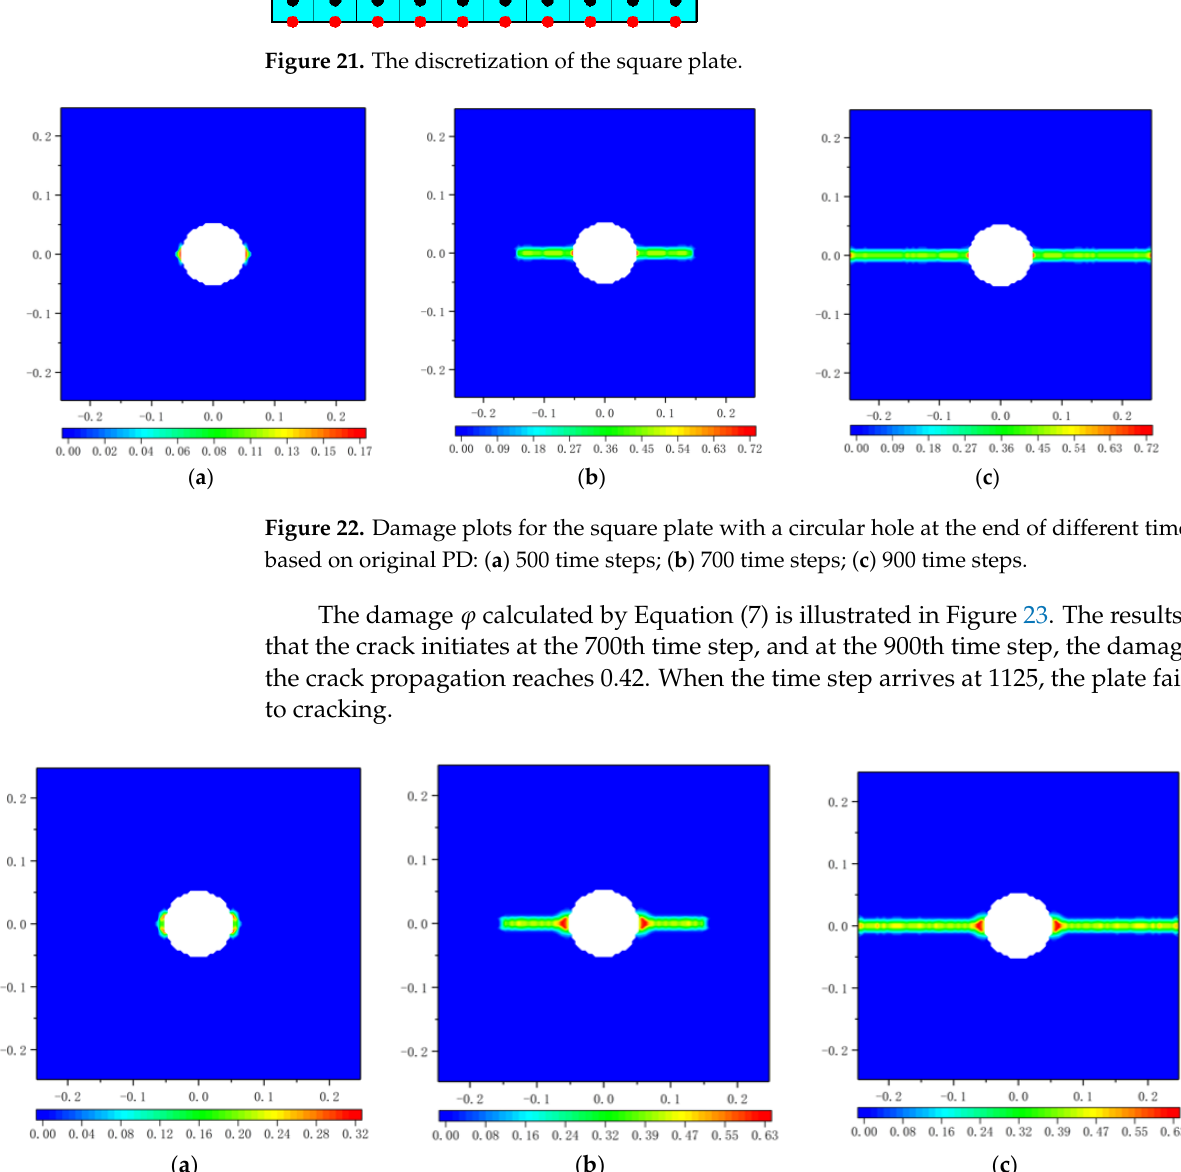
based on Equation (7): ( a ) 700 time steps; ( b ) 900 time steps; ( c ) 1125 time steps.